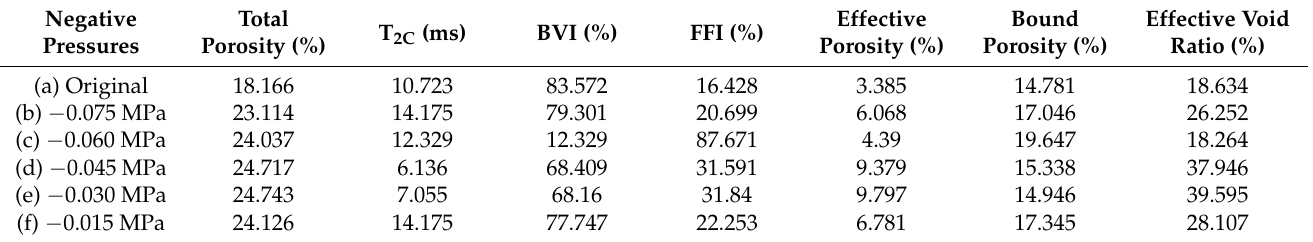
Table 6. Coal sample porosity based on the NMR-T 2C